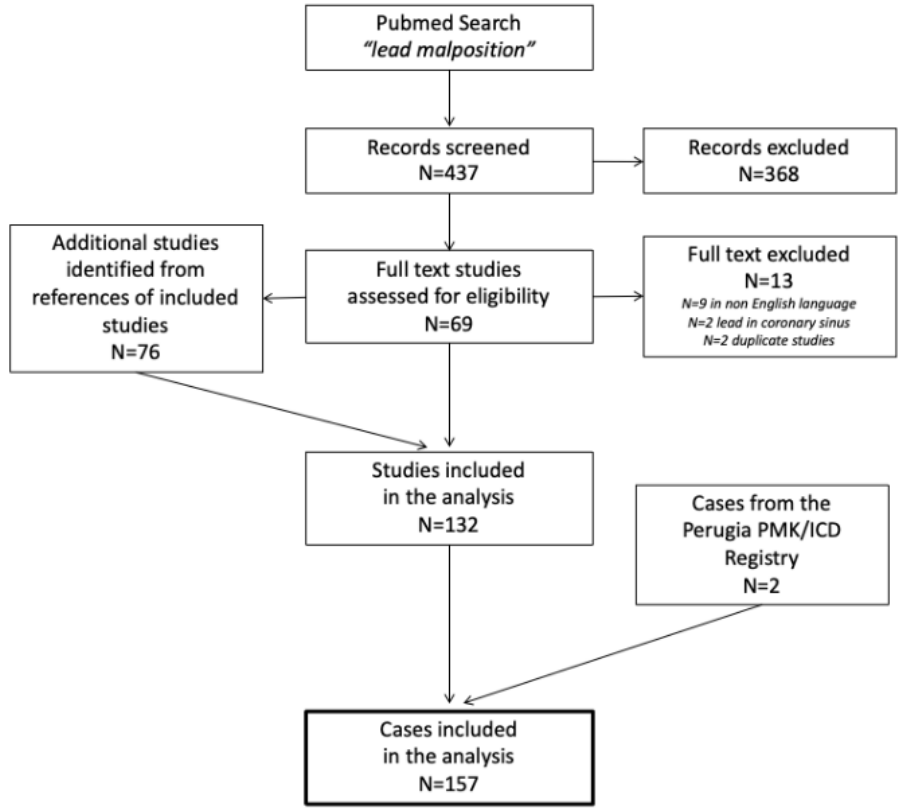
Figure 1. Flow diagram of the study.